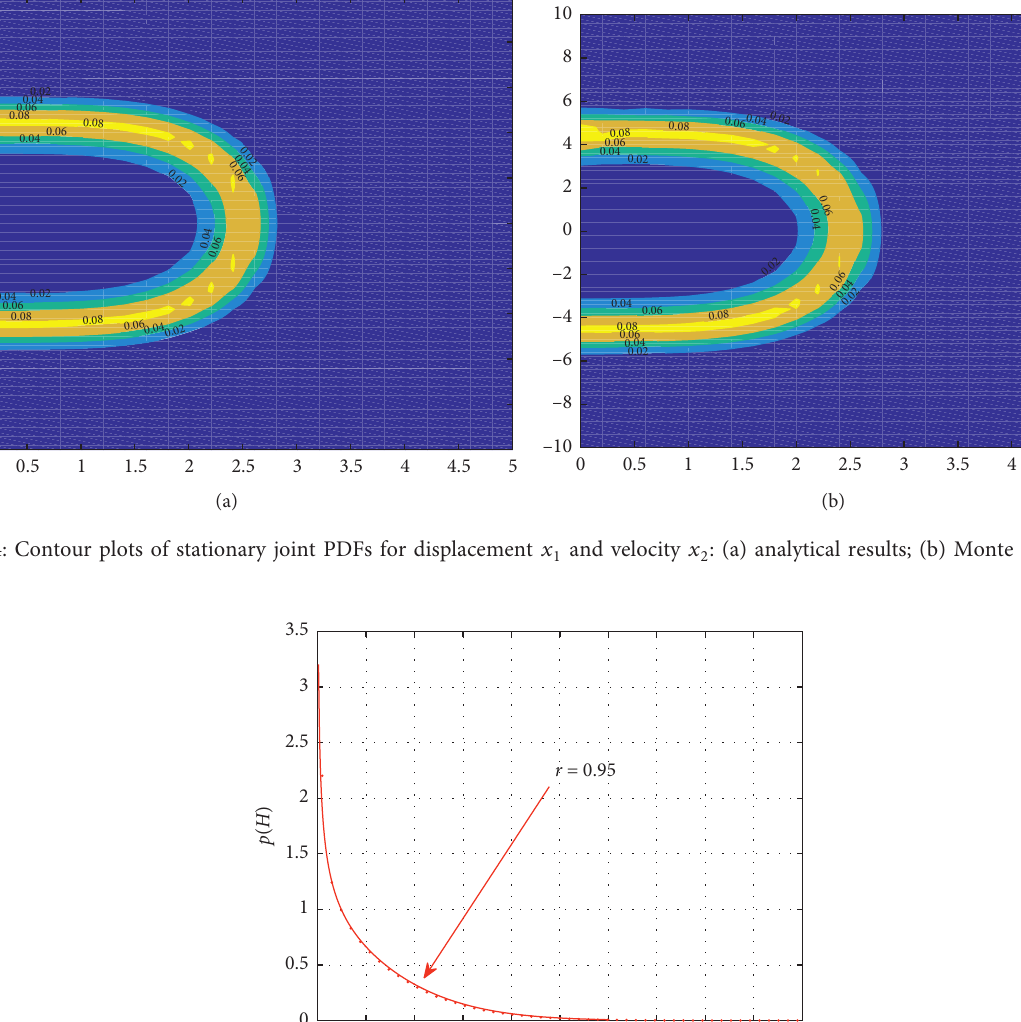
and velocity x : (a) analytical results; (b) Monte Carlo results. 1 2